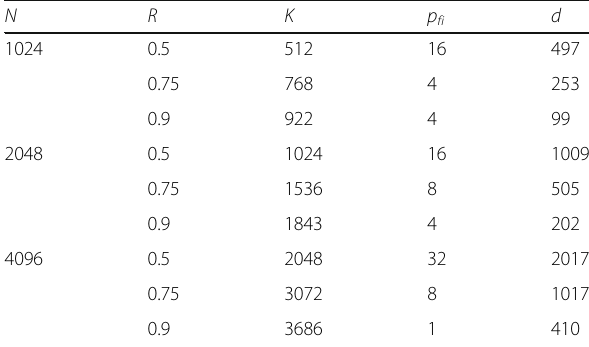
Table 2 Detailed data of d